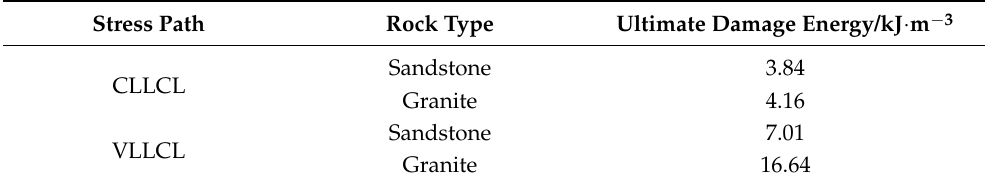
Table 2. The ultimate damage energies under different stress